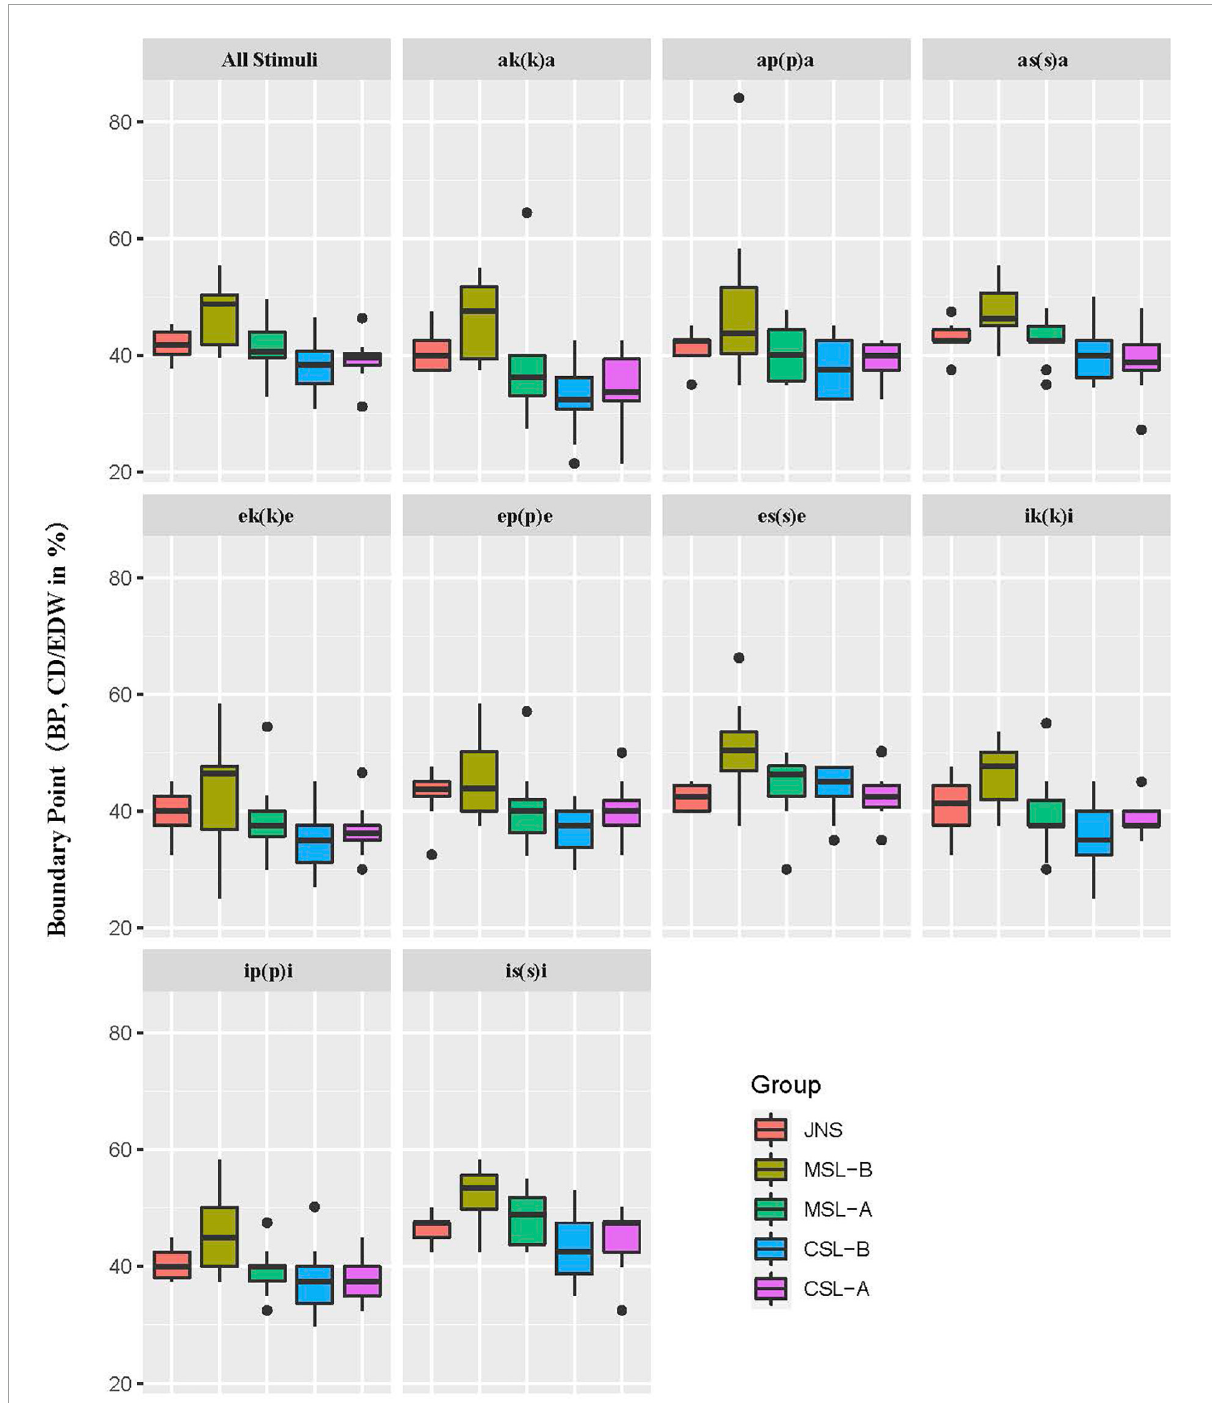
FIGURE4 Average values of categorical boundary point by five groups for all stimuli and for each minimal pair.